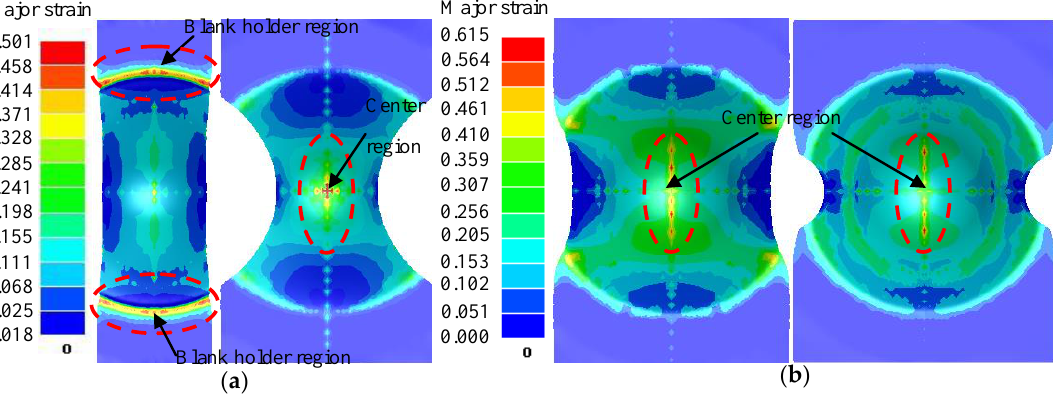
Figure 5. Major strain distributions of specimens with different shapes. ( a ) Rectangular and dumbbell-shaped parts with width of 30 mm. ( b ) Rectangular and dumbbell-shaped parts with width of 60 mm.